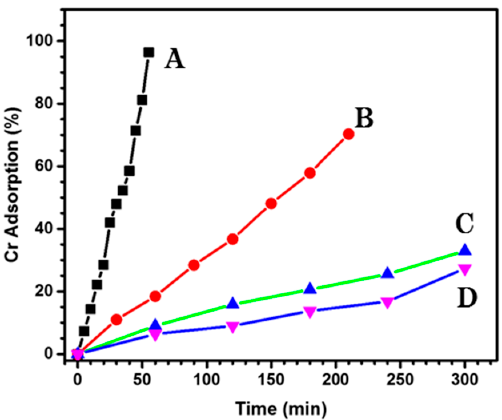
Figure 5. Effect of contact time on Cr (VI) removal (%) using ( A ) G/PANI/FG1; ( B ) G/PANI/FG2; ( C ) G/PANI/FG3; and ( D ) PANI/GNG on adsorption % of Cr (VI). Cr (VI) = 0.5 mM, pH = 2, and temperature = 25 °C.